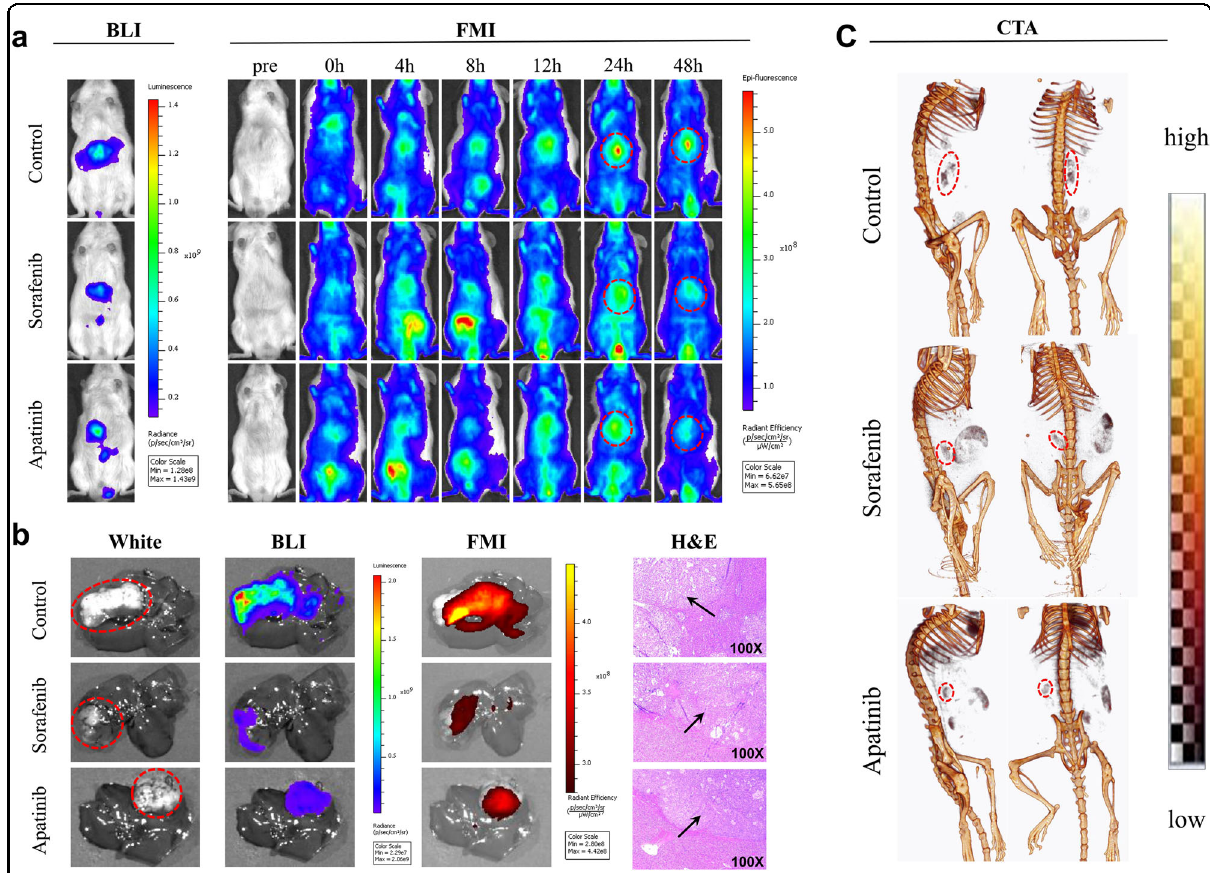
Fig. 4 BLI, FMI, and CTA in orthotopic liver tumor-bearing mice on day 20 post-drug treatment ( n = 3). a In vivo BLI and FMI of control and sorafenib and apatinib treatment groups at the time points of pretreatment and 0, 4, 8, 12, 24, and 48 h post-treatment of AngioSense 750 EX. b Ex vivo white light imaging, BLI, and FMI livers from mice and H&E staining of liver tumor specimens at 48 h post-treatment with AngioSense 750 EX. Black arrows indicate tumor tissues. c The 3D CTA in the control and sorafenib and apatinib treatment groups 15 min after Fenestra VC injection. The red dotted line denotes tumor blood vessel